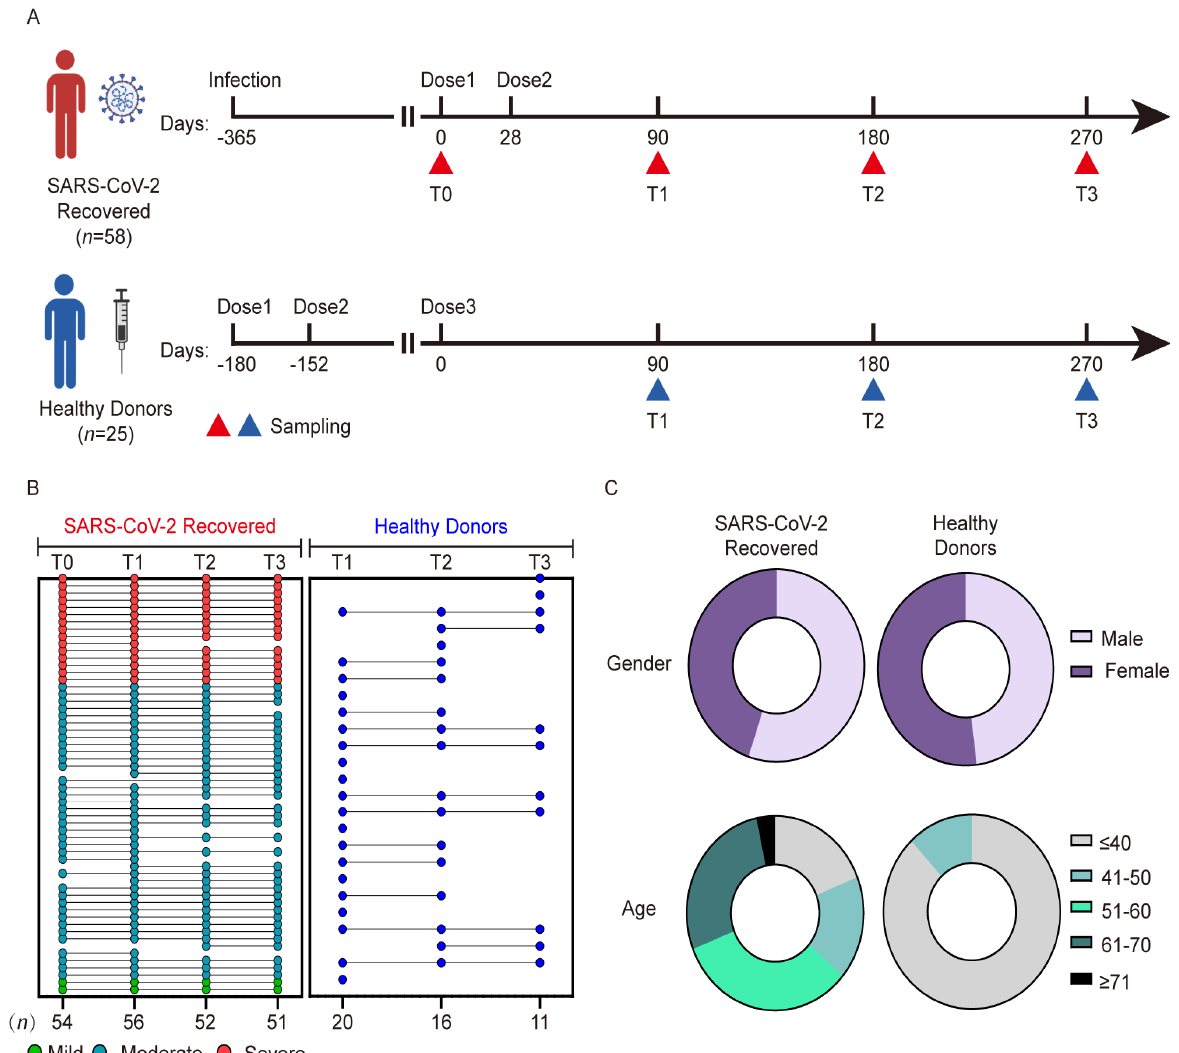
Figure 1. Individuals with previous SARS-CoV-2 infection and healthy donor cohorts and study design. ( A ) Study design of the vaccine cohort. Red and blue triangles indicate sampling collections, the numbers above the triangles indicate the days after the vaccination, and the timepoint for sampling is below the triangles. ( B ) Participants received the SARS-CoV-2 inactivated vaccine and donated blood at four visits. Disease severity status in individuals with previous SARS-CoV-2 infection is color-coded: mild (light green), moderate (dark green), or severe (red). Healthy donors are shown in blue. The bottom row displays the number of samples collected for each timepoint. ( C ) The pie plots show the distribution of sex and age in the two